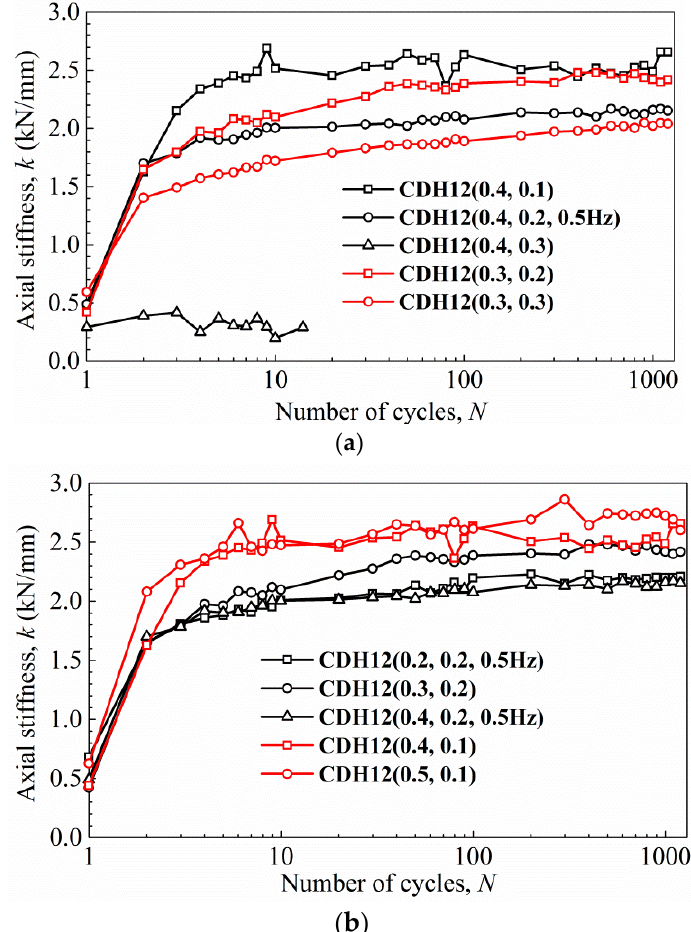
Figure 13. Developments of axial stiffness for different amplitudes and mean cyclic loads: ( a ) different